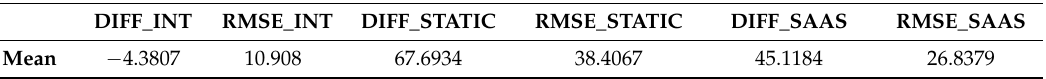
Figure 5. ( a ) The DIFF between ZTD of three models and IGS ZPD in 2016 ( b ) The RMSE between ZTD of three models and IGS ZPD in 2016. Table 1. Comparisons of the mean DIFF(:mm) and RMSE(:mm) of the three models.